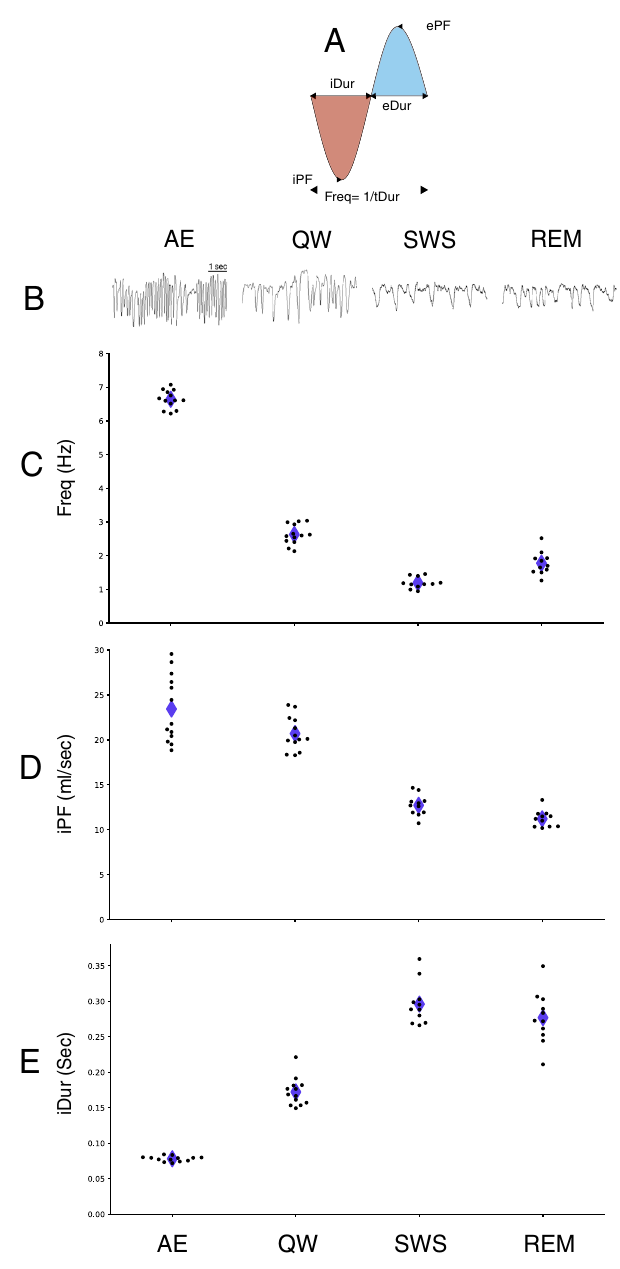
Figure 2. Respiration regimes associated with brain states. ( A) Schematic representation of measured respiratory features. ( B) Examples of respiration raw traces during active exploration (AE), quiet waking (QW), slow-wave sleep (SWS) and rapid eye movements sleep (REM). ( C–E ) Scatter plot of respiration features measured during each brain state (average per rat): frequency (Freq, C ), inspiration peak flow rate (iPF, D ), and inspiration duration (iDur, E ). Repeated measure ANOVA tests with the 11 rats recorded in all states show significant effects of state on all respiratory features (see main text for details). Black dots: individual values per animal; Purple diamonds: